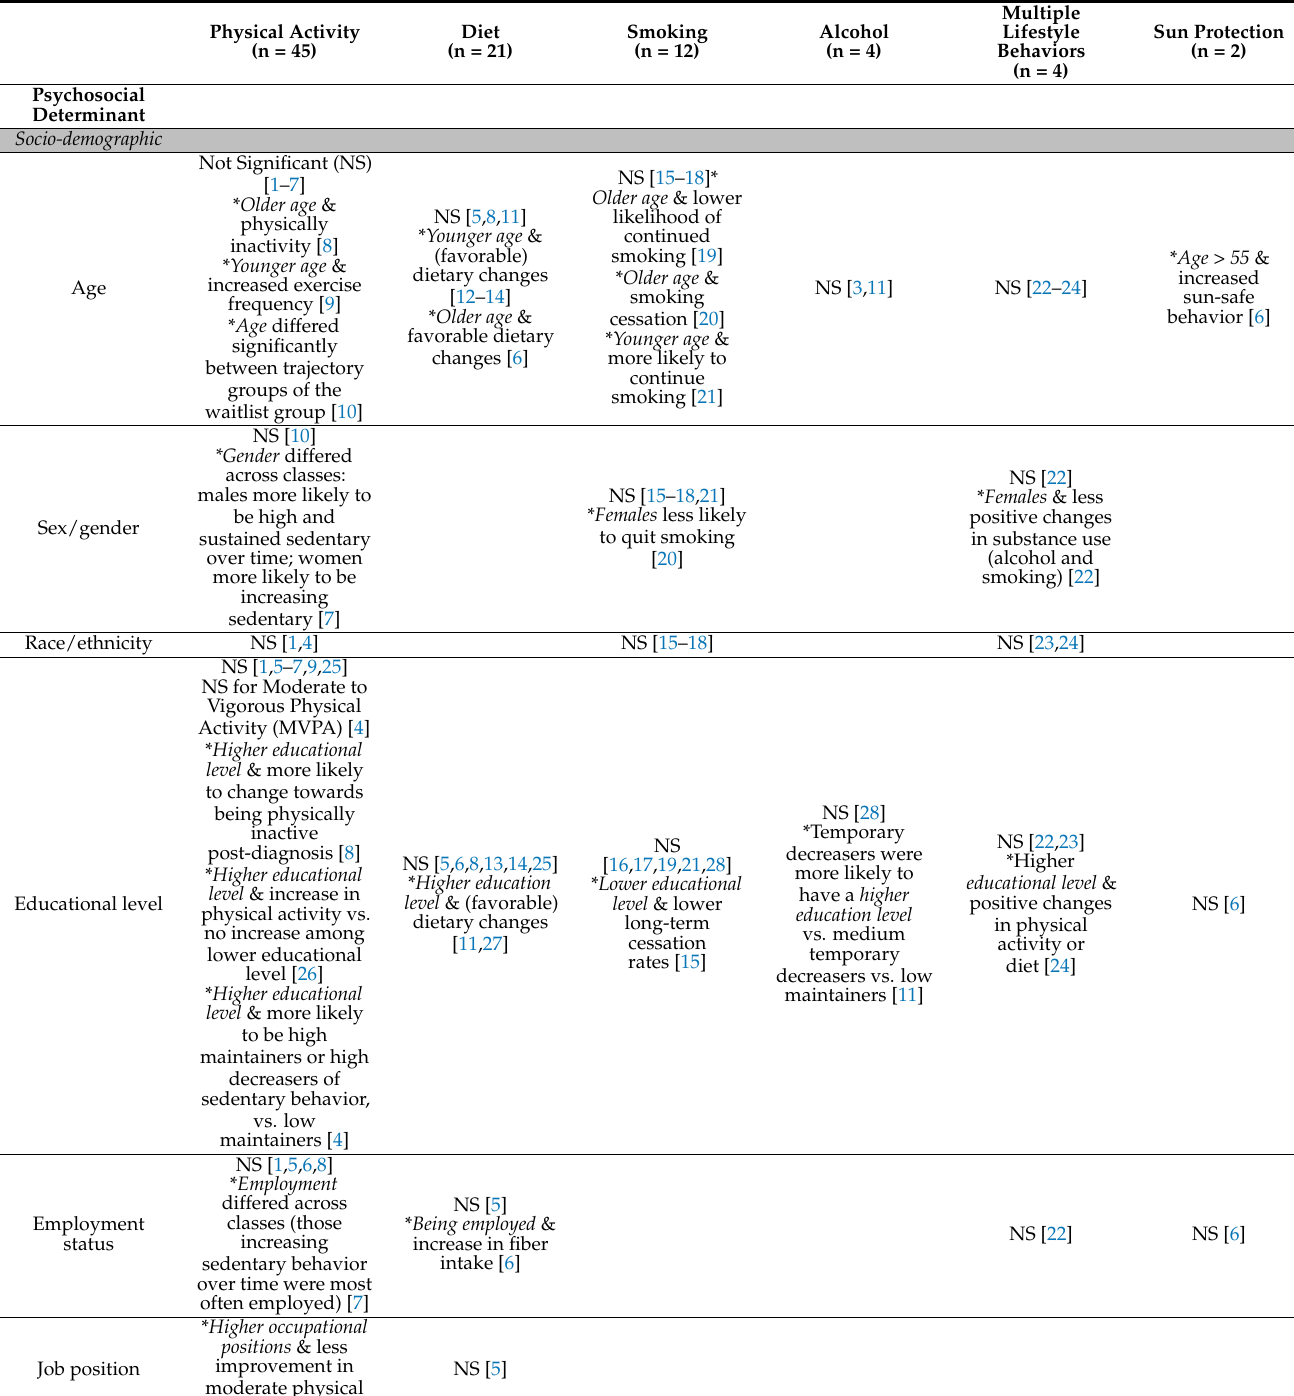
Table 2. Overview of included quantitative studies on psychosocial determinants of (favorable) lifestyle changes in cancer